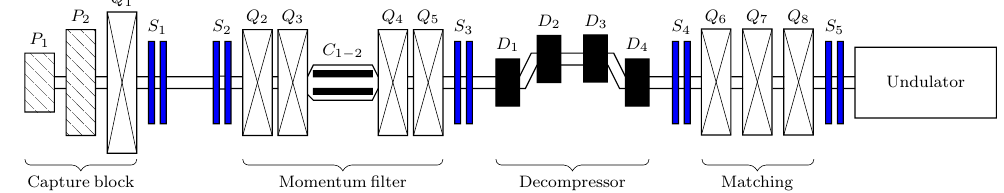
Figure 1. Schematic diagram representing proposed beamline. Here, P 1 and P 2 are permanent quadrupole magnets, Q 1 – Q 8 are electromagnetic quadrupoles, C 1 vertical collimators, S 1 – S 5 are pairs of steering magnets (vertical and horizontal) and D 1 – D 4 are dipole magnets of the decompressor